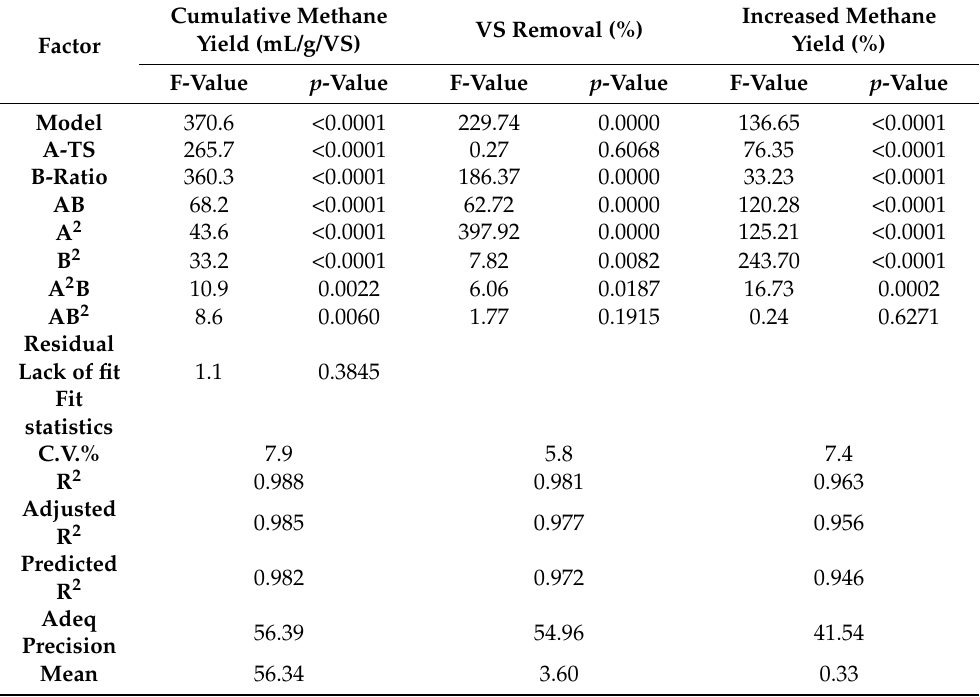
Table 6. Analysis of variance for the cumulative methane yield, VS removal and increased methane